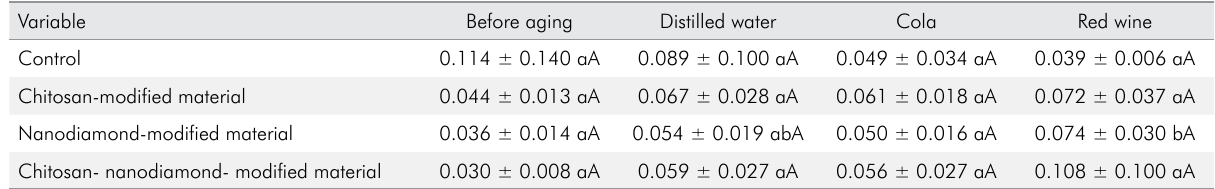
Table 2. Results of the Ra surface roughness of the materials before and after aging in different solutions. Variable